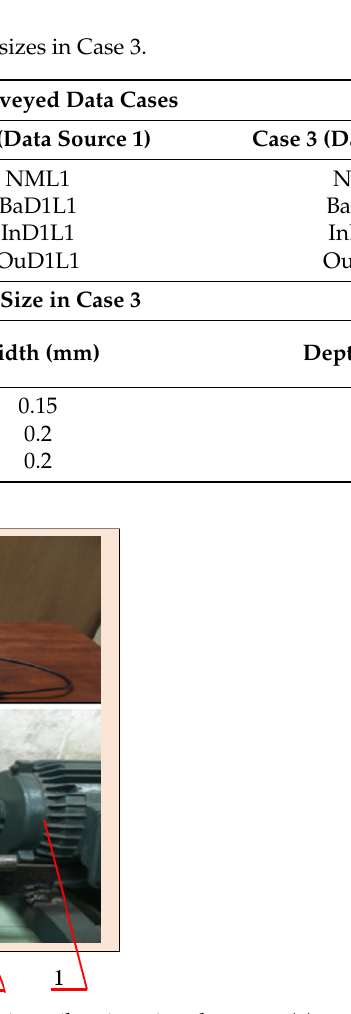
Figure 1. Experimental apparatus for measuring vibration signal: motor ( 1 ), acceleration sensors ( 3 ) and ( 5 ), the surveyed bearings ( 2 ) and ( 4 ), the module for processing and transforming series vibra ‐ tion signal (Model: NI ‐ 9234) ( 6 ), the gearbox and the brake used for changing load ( 7